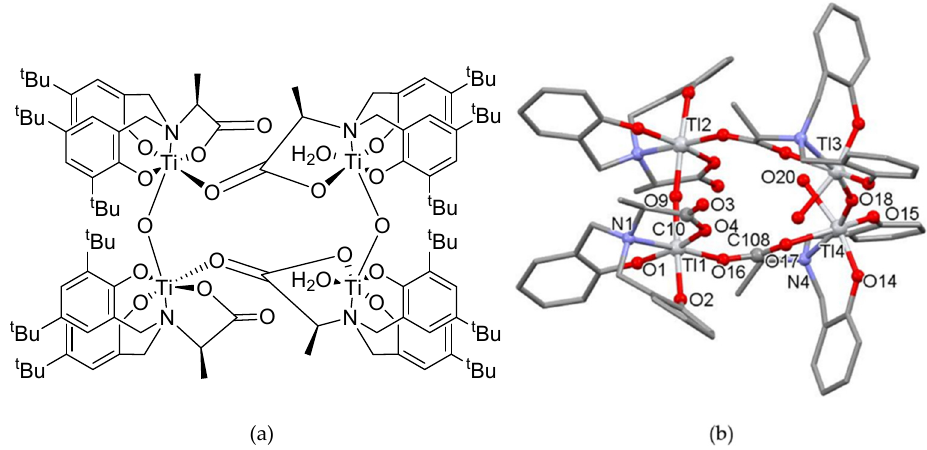
Figure 4. Structure of Ti cluster 5 ( a ) and Crystal structure of 5 ( b ), Hydrogens, tert -butyl groups and solvent omitted for clarity. Selected bond lengths for 5 (Å): Ti1-O1 1.844(4), Ti1-O2 1.935(4), Ti1-O4 2.001(4), Ti1-O9 1.847(4), Ti1-O16 1.994(4), Ti1-N1 2.257(5), Ti4-O14 1.833(4), Ti4-O15 1.820(4), Ti4-O17 2.087(4), Ti4-O18 1.825(3), Ti4-O20 2.106(3), Ti4-N4 2.295(4), O3-C10 1.233(7), O4-C10 1.294(7), O16- C108 1.262(6), O17-C108 1.263(6). Selected bond angles for 5 ( ◦ ): O1-Ti1-O2 92.7(2), O1-Ti1-O16